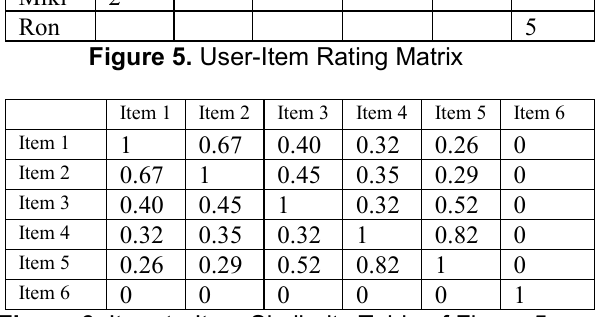
Figure 6. Item-to-Item Similarity Table of Figure